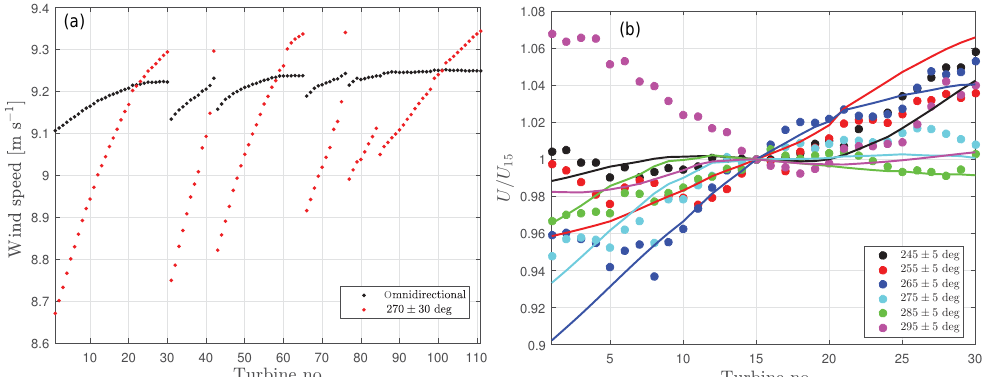
Figure 5. (a) WRF-simulated average wind speed at hub height at the turbine positions of the Anholt wind farm. (b) Average wind speed at hub height (normalized by that of turbine 15) at the most westerly row of the wind farm for a number of westerly flow cases: WRF winds in solid lines and SCADA-derived winds in